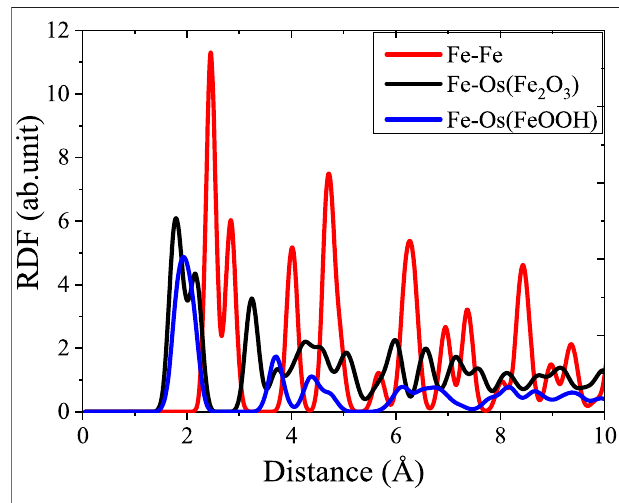
FIGURE 3 | Radial distribution function image of the bond in the three types of structures before